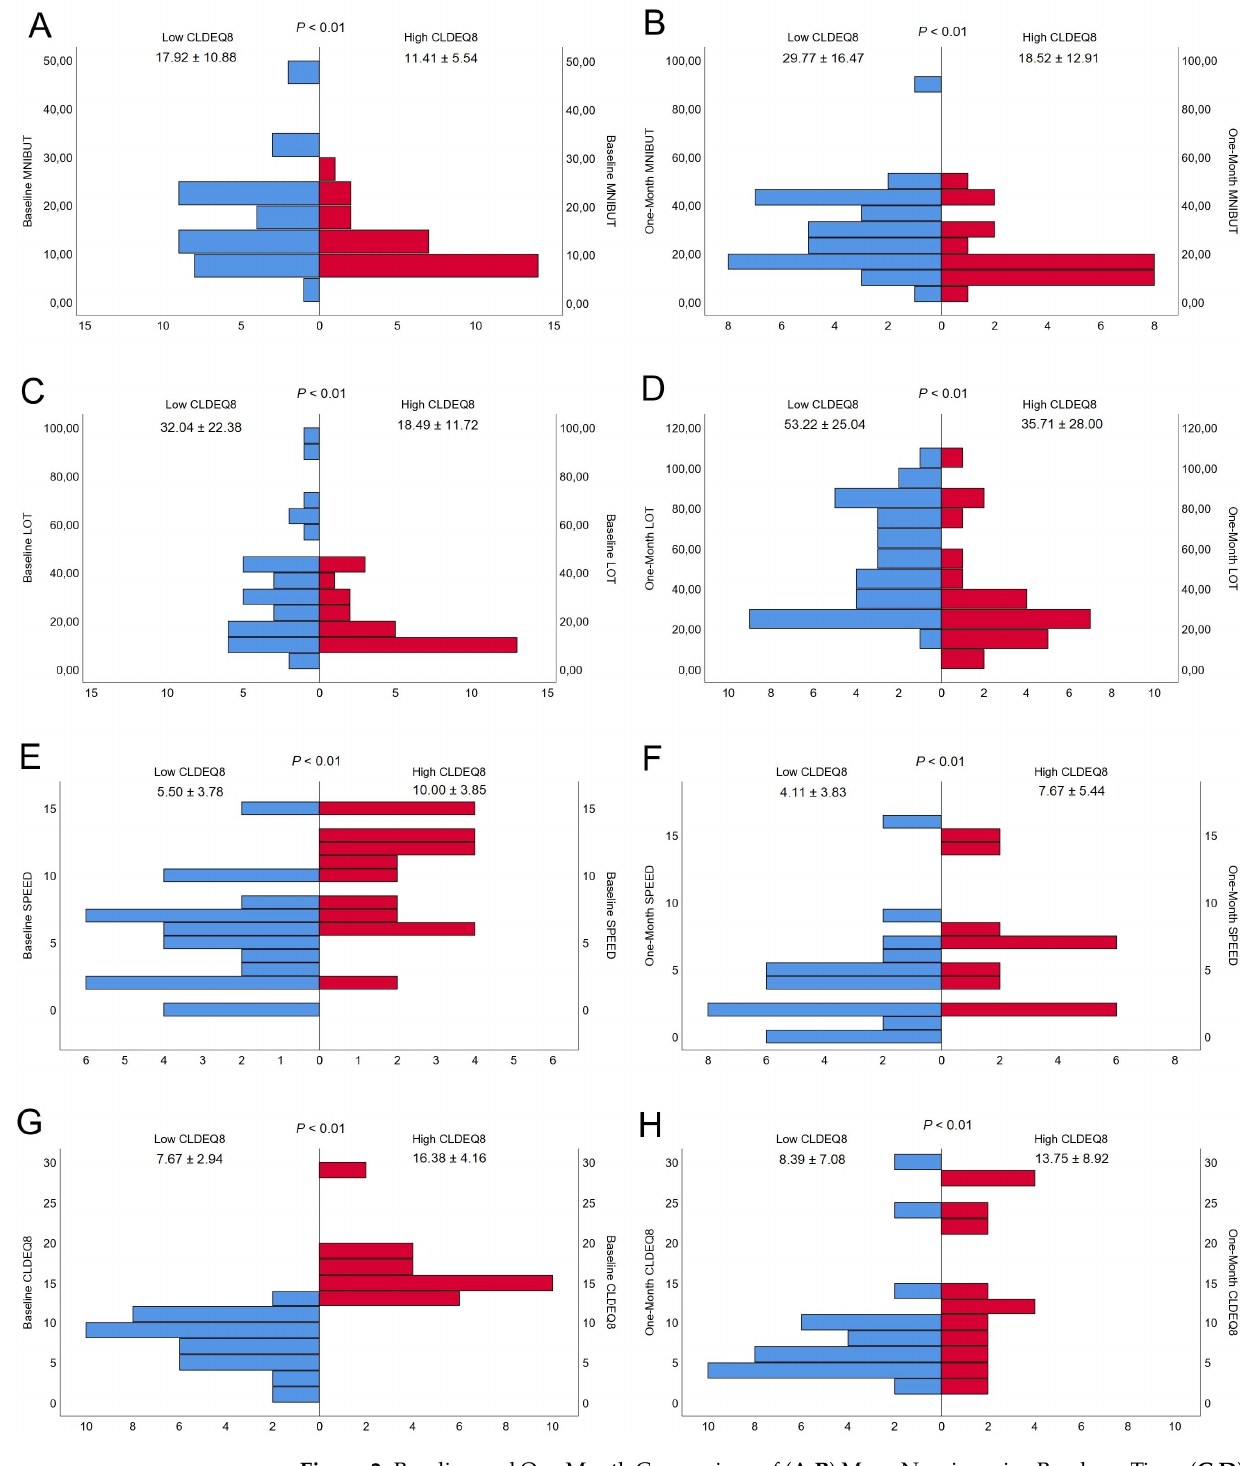
Figure 2. Baseline and One Month Comparison of ( A , B ) Mean Non-invasive Break-up Time, ( C , D ) Lid Opening Time (LOT), ( E , F ) Standard Patient Evaluation of Eye Dryness (SPEED) and ( G , H ) Contact Lens Dry Eye Questionnaire (CLDEQ-8). The figure consists of eight pyramid-shaped graphs, with four left representing the baseline measurements and four right representing the measurements taken one month later.